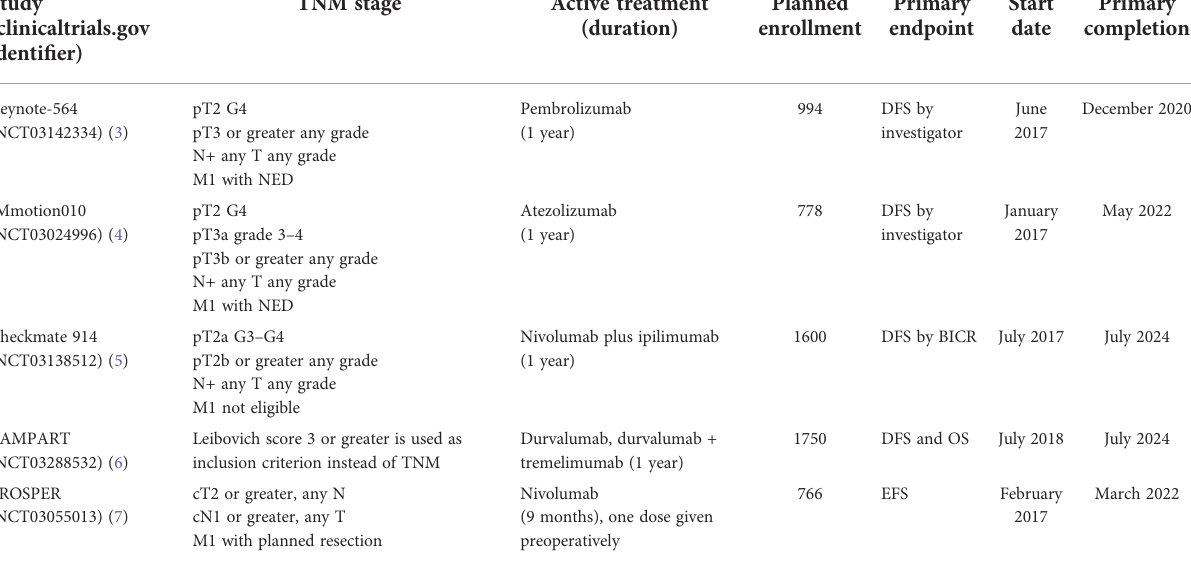
TABLE 1 Neoadjuvant ICI trials. Study